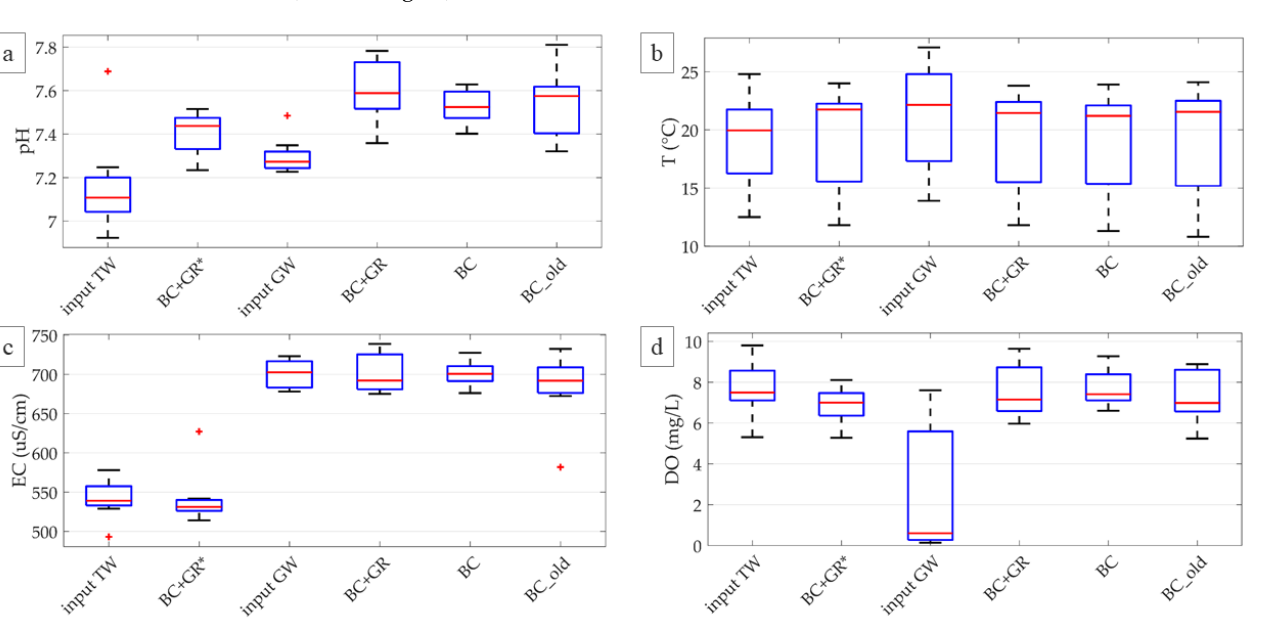
Figure 2. Values of the parameters measured on-site on input (TW and GW) and output samples from all configurations (( a ): pH, ( b ): Temperature, ( c ): EC, ( d ): DO). Median value (red line), 25th and 75th percentiles (blue box), range (black whiskers) and outliers (red cross) are shown.